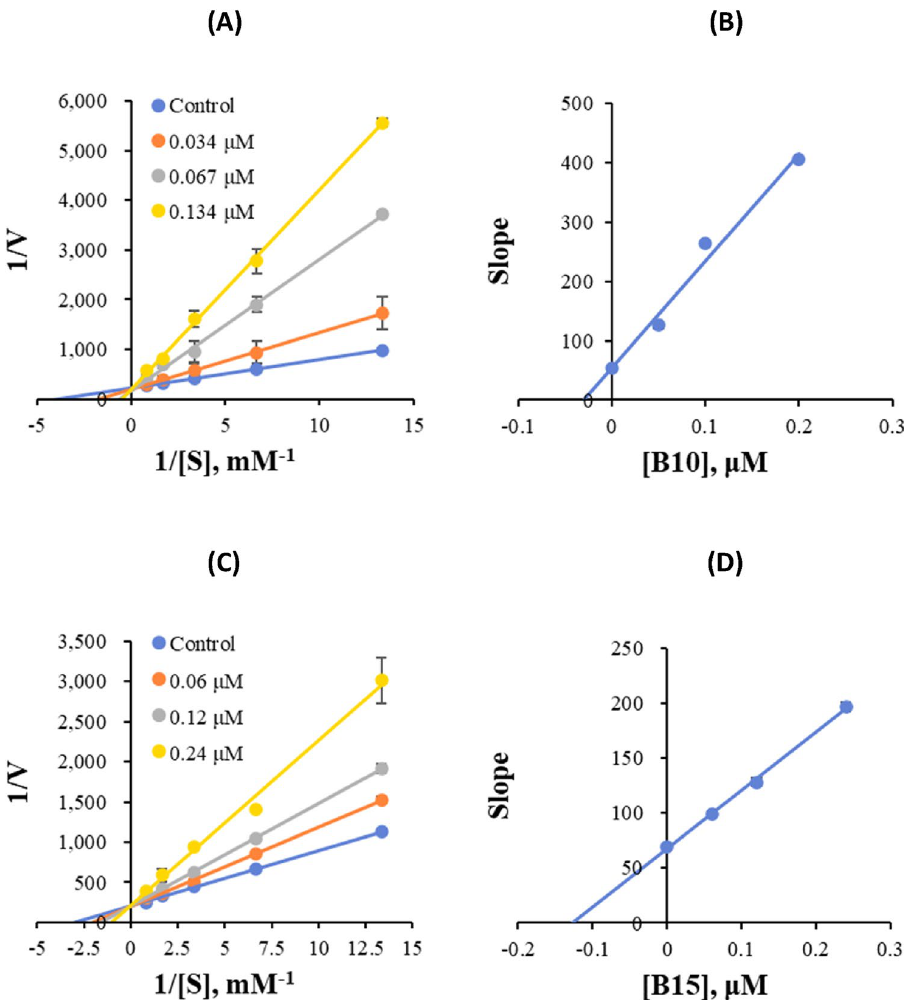
Figure 2. Lineweaver–Burk plots for the inhibition of hMAO-B by B10 ( A ) and B15 ( C ), as well as the corresponding secondary plots of the slope vs inhibitor concentration ( B , D ,